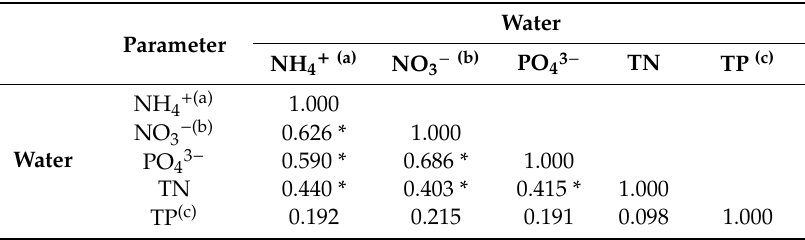
Table 5. Correlations in water (the significance limit of a correlation coe ffi cient based on